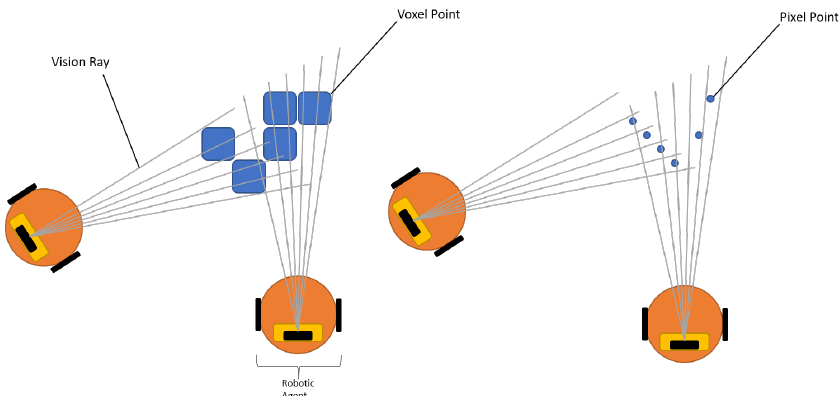
Figure 6. Figure showing the voxel approach to collecting data points.